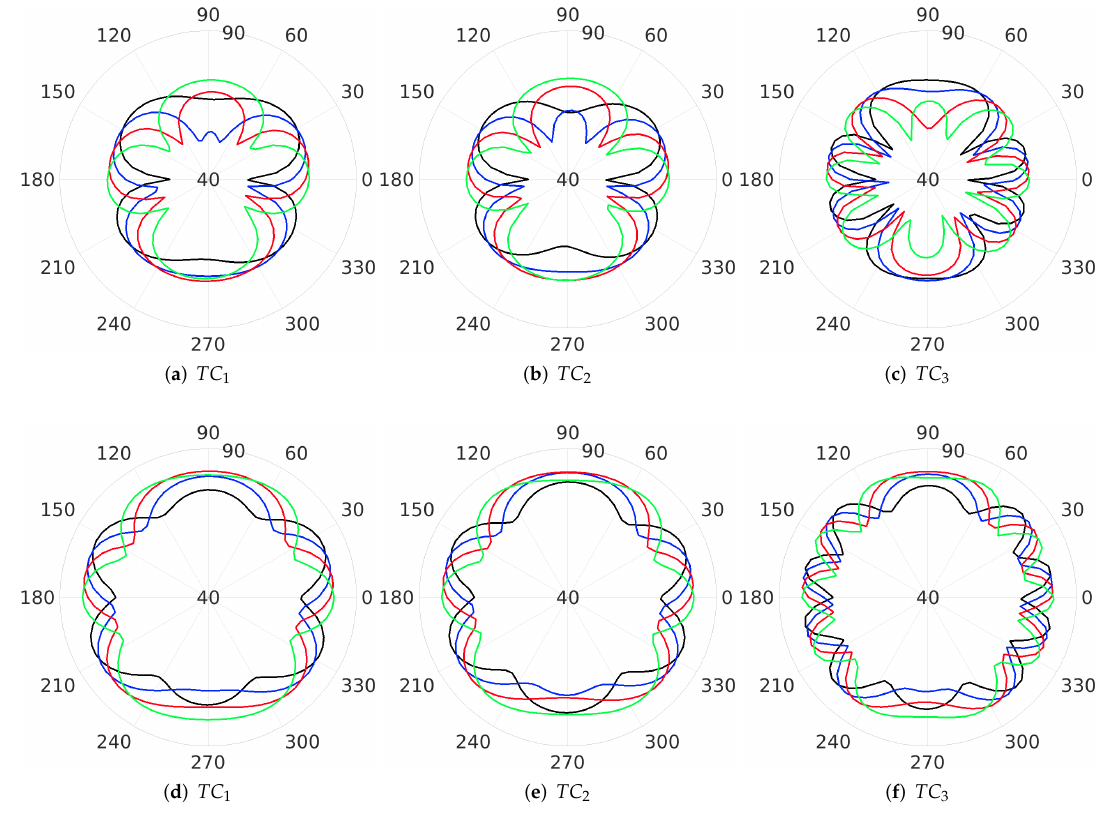
Figure 7. Co-rotating propellers, OASPL directivity pattern on rotor disk for different TCs and different phase shifts (black line γ = 0 ◦ , blue line γ = 12 ◦ , red line γ = 24 ◦ , green line γ = 36 ◦ ); upper M t = 0.52, lower M t =